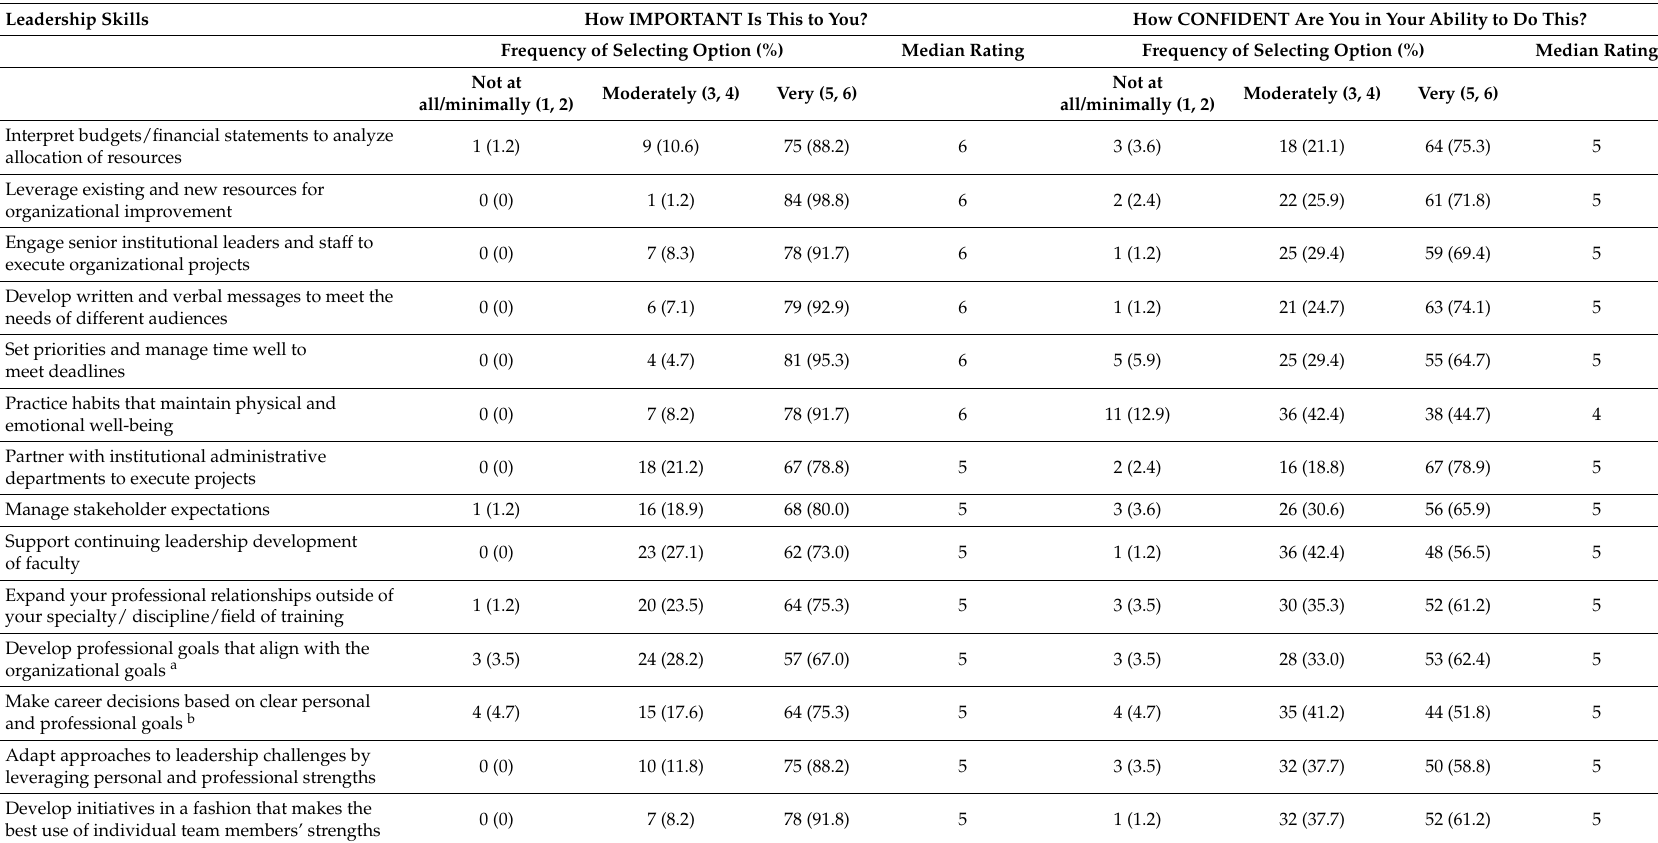
Table 2. Engineering education leaders’ ratings of the importance of and their confidence in leadership